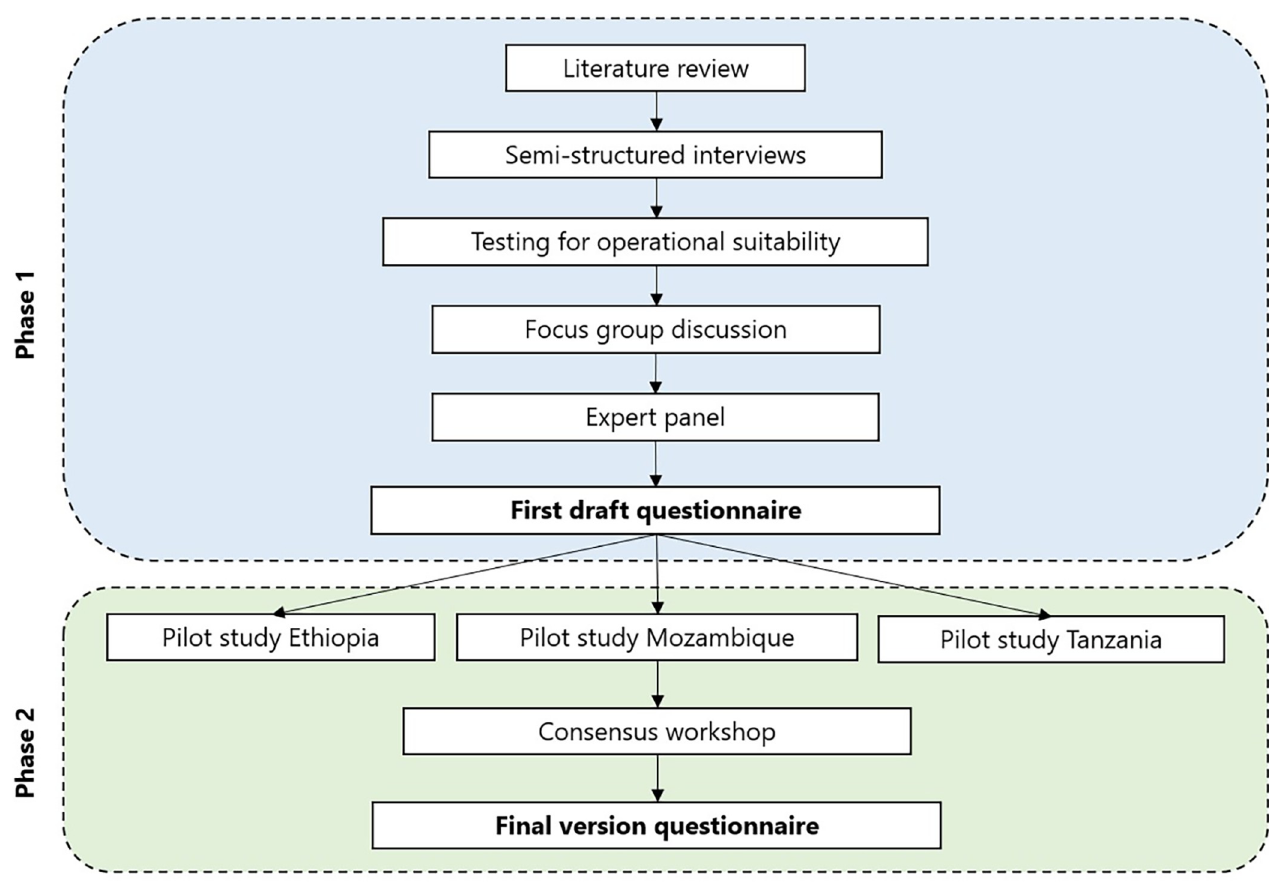
Fig 2. Visualisation of study